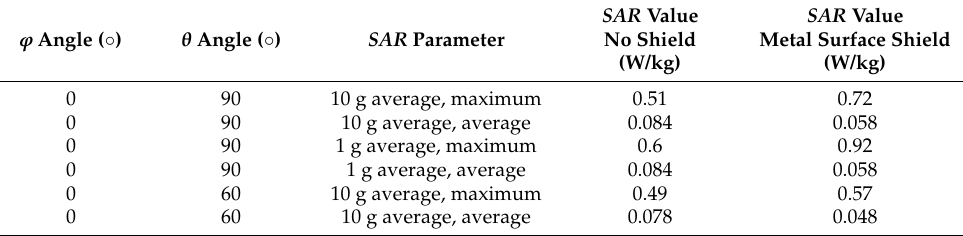
Table A2. SAR parameters for 750 MHz and all combinations of ϕ and θ angles